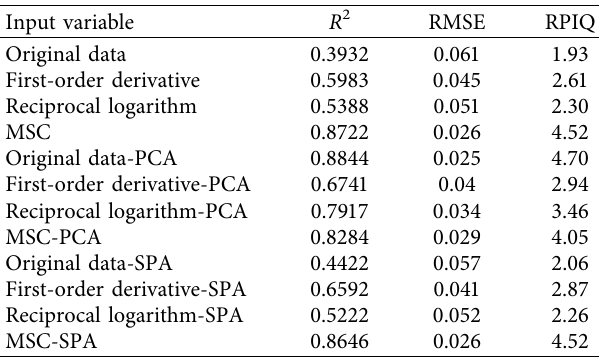
Figure 6: Prediction of the SPA-PLSR model: (a) original data; (b) frst-order derivative; (c) reciprocal logarithm; and (d) MSC.Te black and red lines show the 1:1 relationship and the model trend. Te MSC-SPA-PLSR model falls within the largest number of points within the 95% confdence band. Table 5: Assessment of the GRNN prediction